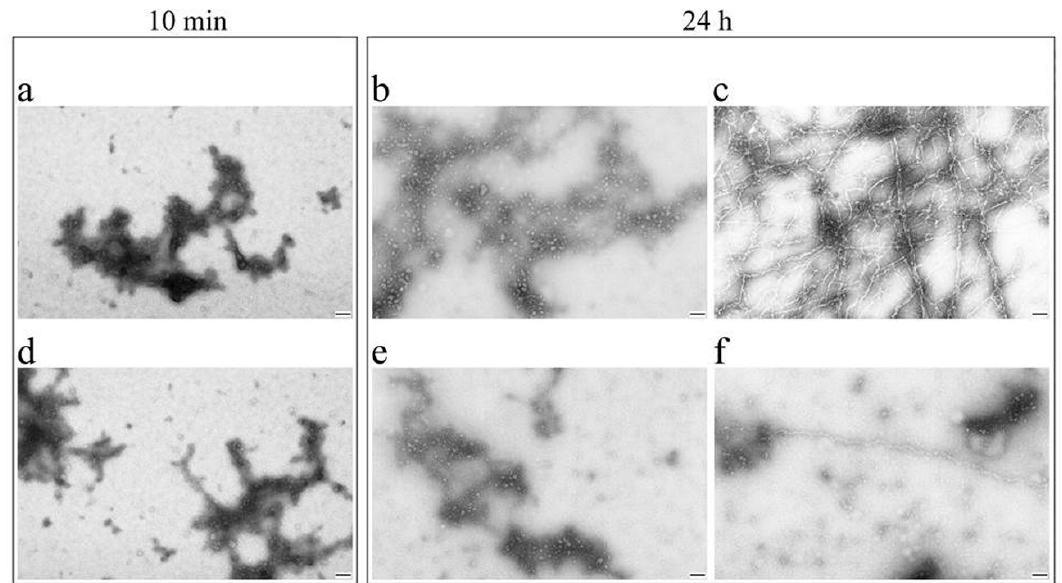
Figure 4. Electron microscopy of negatively stained sMyBP-C aggregates. ( a , d ) Amorphous aggregates and oligomers of sMyBP-C were obtained by placing it into a solution of 0.15 M glycine–KOH, pH 7.0, at 4 °C for 10 min; ( b , e ) sMyBP-C amorphous aggregates and oligomers as the main form of the aggregated protein were obtained by placing it into a solution of 0.15 M glycine–KOH, pH 7.0, at 4 °C for 24 h. ( c ) Fibrils of sMyBP-C were obtained by placing it into a solution of 0.15 M glycine–KOH, pH 7.0, at 4 °C for 24 h. ( f ) A separately lying fibrillar filament and oligomers of sMyBP-C were obtained by placing it into a solution of 0.15 M glycine–KOH, pH 7.0, at 4 °C for 24 h. Staining, by 2% aqueous uranyl acetate. Scale, 100 nm. The original images are at: https://drive.google.com/drive/folders/1UBx6m-Aa4Dl2In_PjiAweqmR6zyxVBz2?usp=sharing.